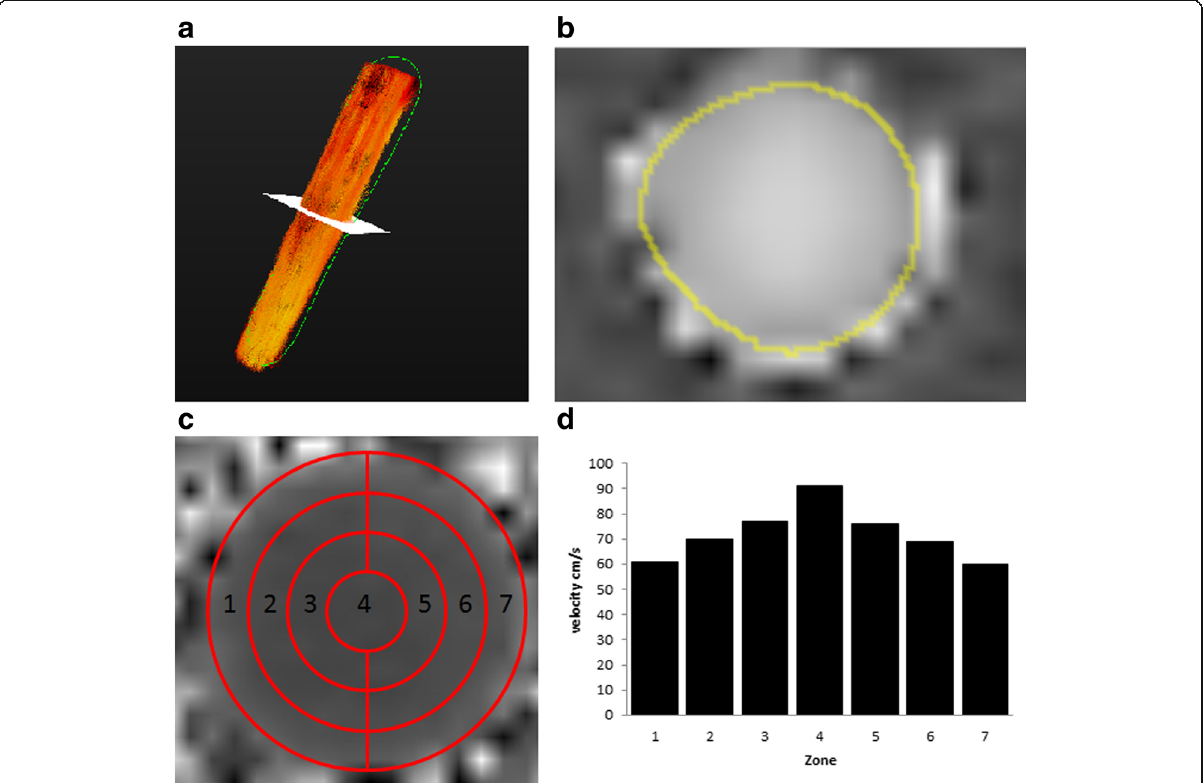
Fig. 2 a Visualisation of constant flow inside the phantom vessel with time-resolved 3D pathlines (red). The yellow plane represents the measuring plane depicted in b . b Phase-contrast images obtained with the k-t- GRAPPA5 sequence showing a cross-section through the phantom vessel on the same level as in a . c Cross-section of the phantom vessel on a k-t- GRAPPA5 image subdivided into seven circular sectors. d Distribution of the flow velocities in the constant flow phantom within the seven circular sectors defined in c demonstrates a parabolic shape with higher flow velocities in the centre. cm/s, centimetres per